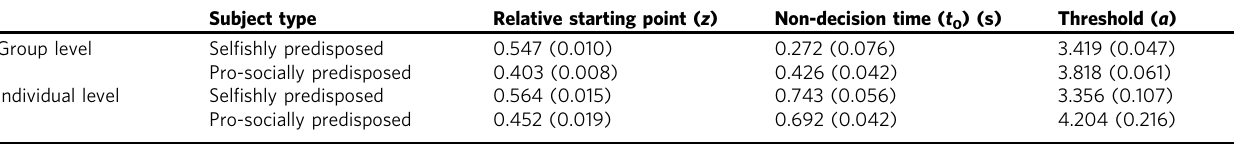
Table 1 Estimation results of the biased DDM